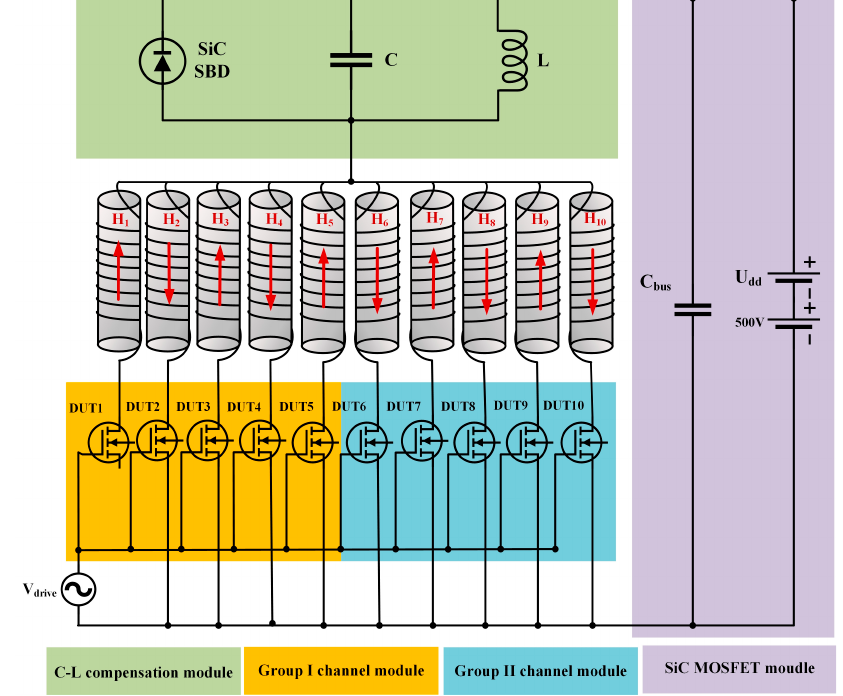
Figure 5. Schematic diagram of DUT1–DUT10 multi-channel parallel model using ferrite inductance. In parallel branches, the current in each 1-10 branch is i d1 , i d2 , i d3 , · · · · · · i d10 . The difference in parallel current sharing is ∆ i ab (1 ≤ b < a ≤ 10), as shown in Equation (1): The magnetic field intensity excited by i d1 , i d2 , i d3 , · · · · · · i d10 for each 1–10 branch is H 1 , H 2 ······ H 10 . The difference in parallel current sharing | ∆ i ab | is,